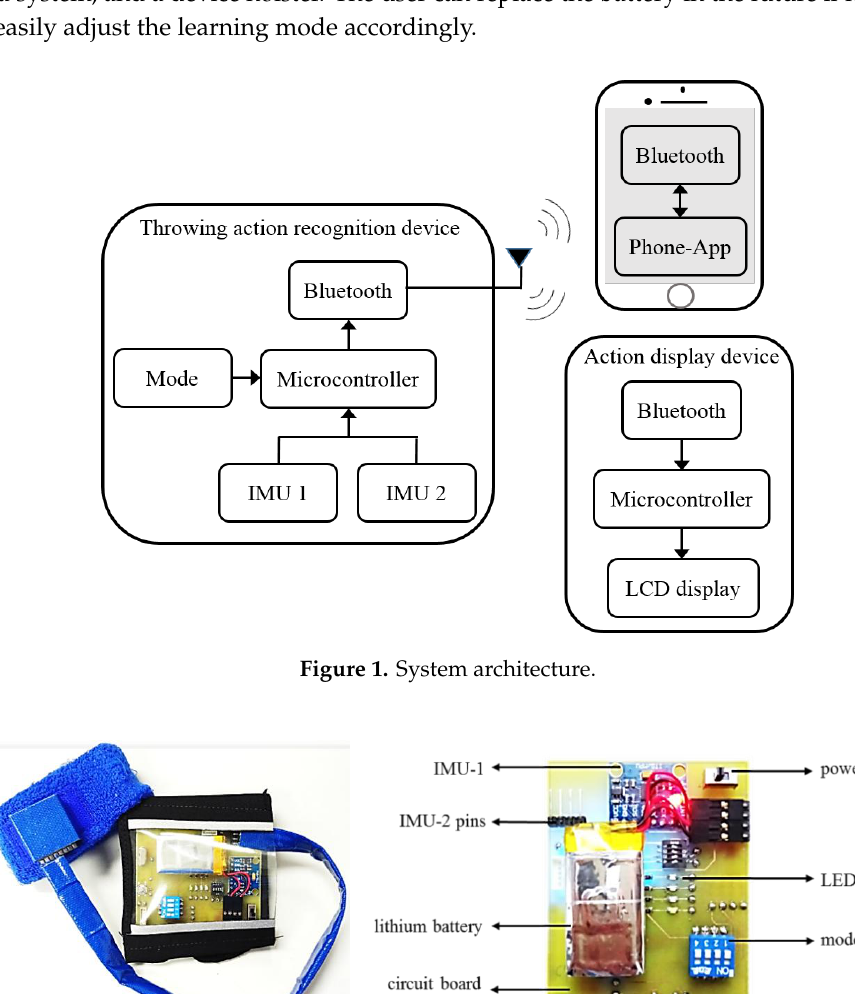
Figure 1. System architecture.